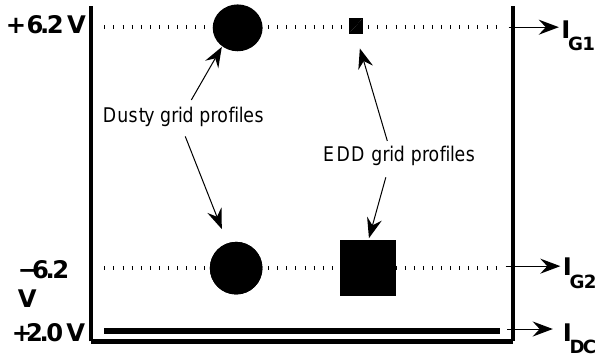
Fig. 1. The principle of the EDD probe, with its upper and lower grids of square profiles and the circular ones for DUSTY. The grid profiles are not shown to scale. The side edges are 1mm for G2 and 0.25mm for G1. For DUSTY both grids have profiles with diameter of